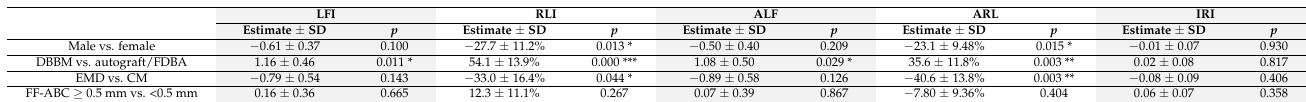
Table 2. Generalized linear model for the effects of the demographic characteristics, treatment strategies, and furcation-ABC relationship, on the outcome of FDR in the pure furcation defect group. The data was adjusted by age.